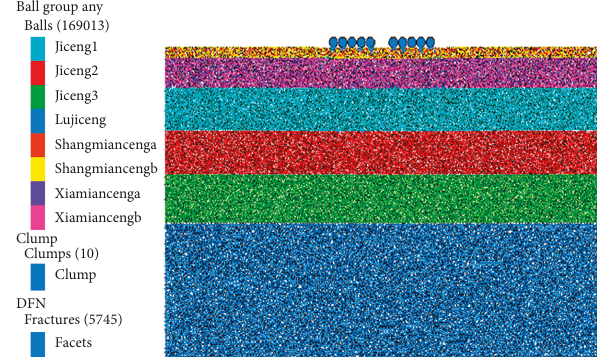
Figure 8: Microcrack shape in